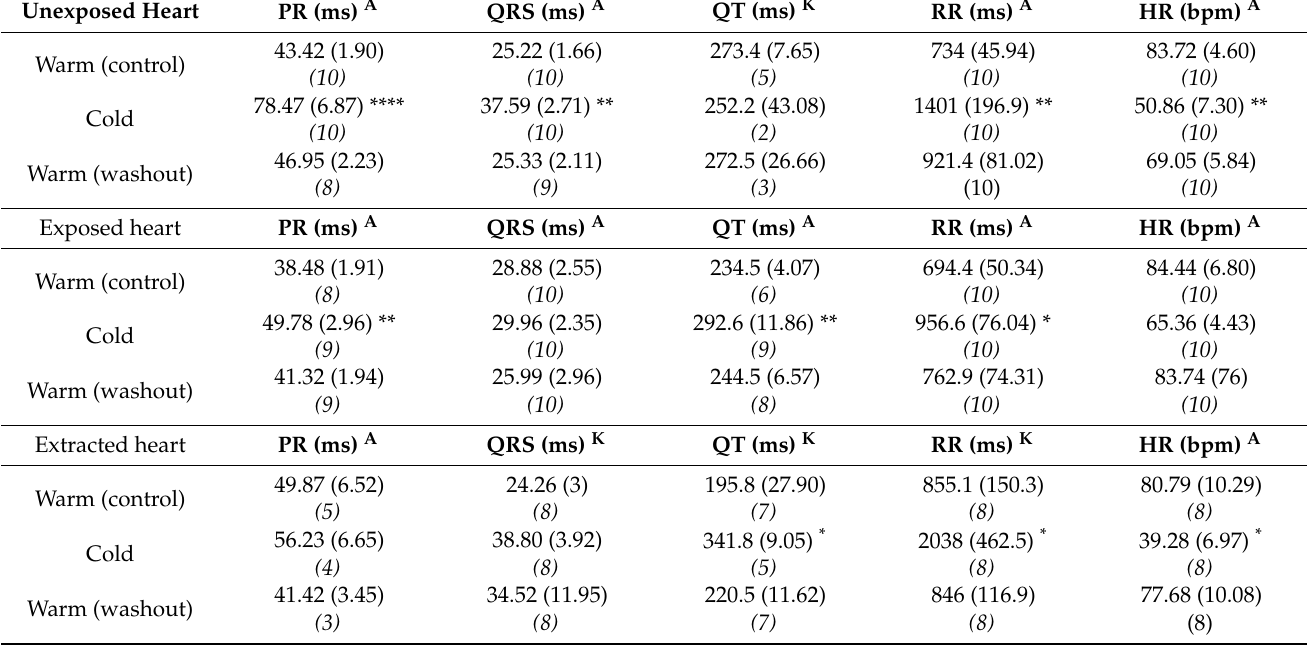
Table 4. Effects of temperature on the characteristics of the ECG. Data are presented as mean (SEM). The sample size ( n ) is indicated in italic in brackets for each parameter in the table. P values were calculated using either a one-way ANOVA( A ) or the Kruskal-Wallis( K ) test. * p < 0.05, ** p < 0.01, **** p <